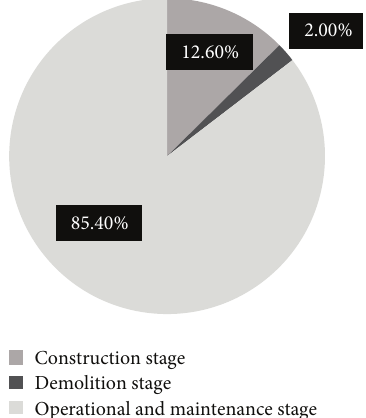
Figure 1: Percentage of CO 2 emissions produced in a building life cycle